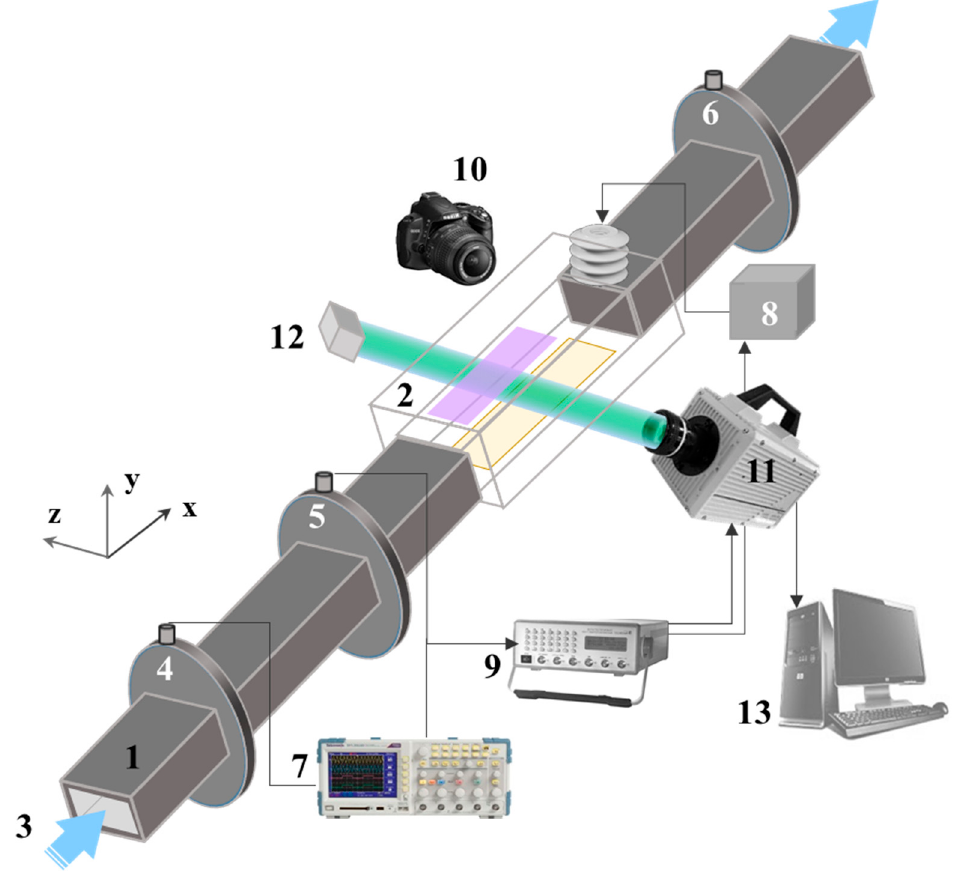
Figure 1. Scheme of the experimental setup: (1) shock tube; (2) discharge chamber; (3) flow direction; (4–6) pressure sensors; (7) oscilloscope; (8) high-voltage block; (9) delay generator; (10) photo camera; (11) high-speed camera/ICCD camera, (12) optical shadowgraphy system; (13) PC. Arrows indicate the flow direction.